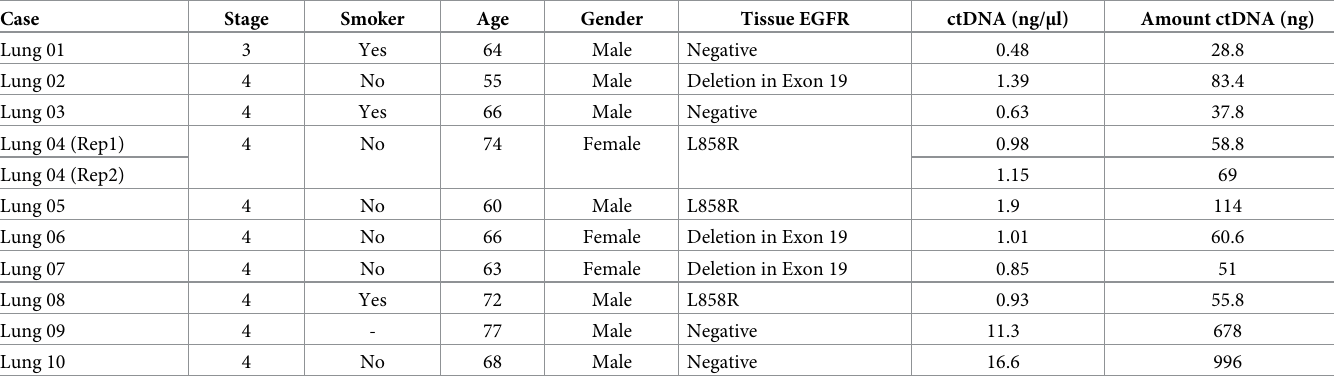
Table 1. Demographics and clinical characteristics of 10 lung cancer patients enrolled in this study.